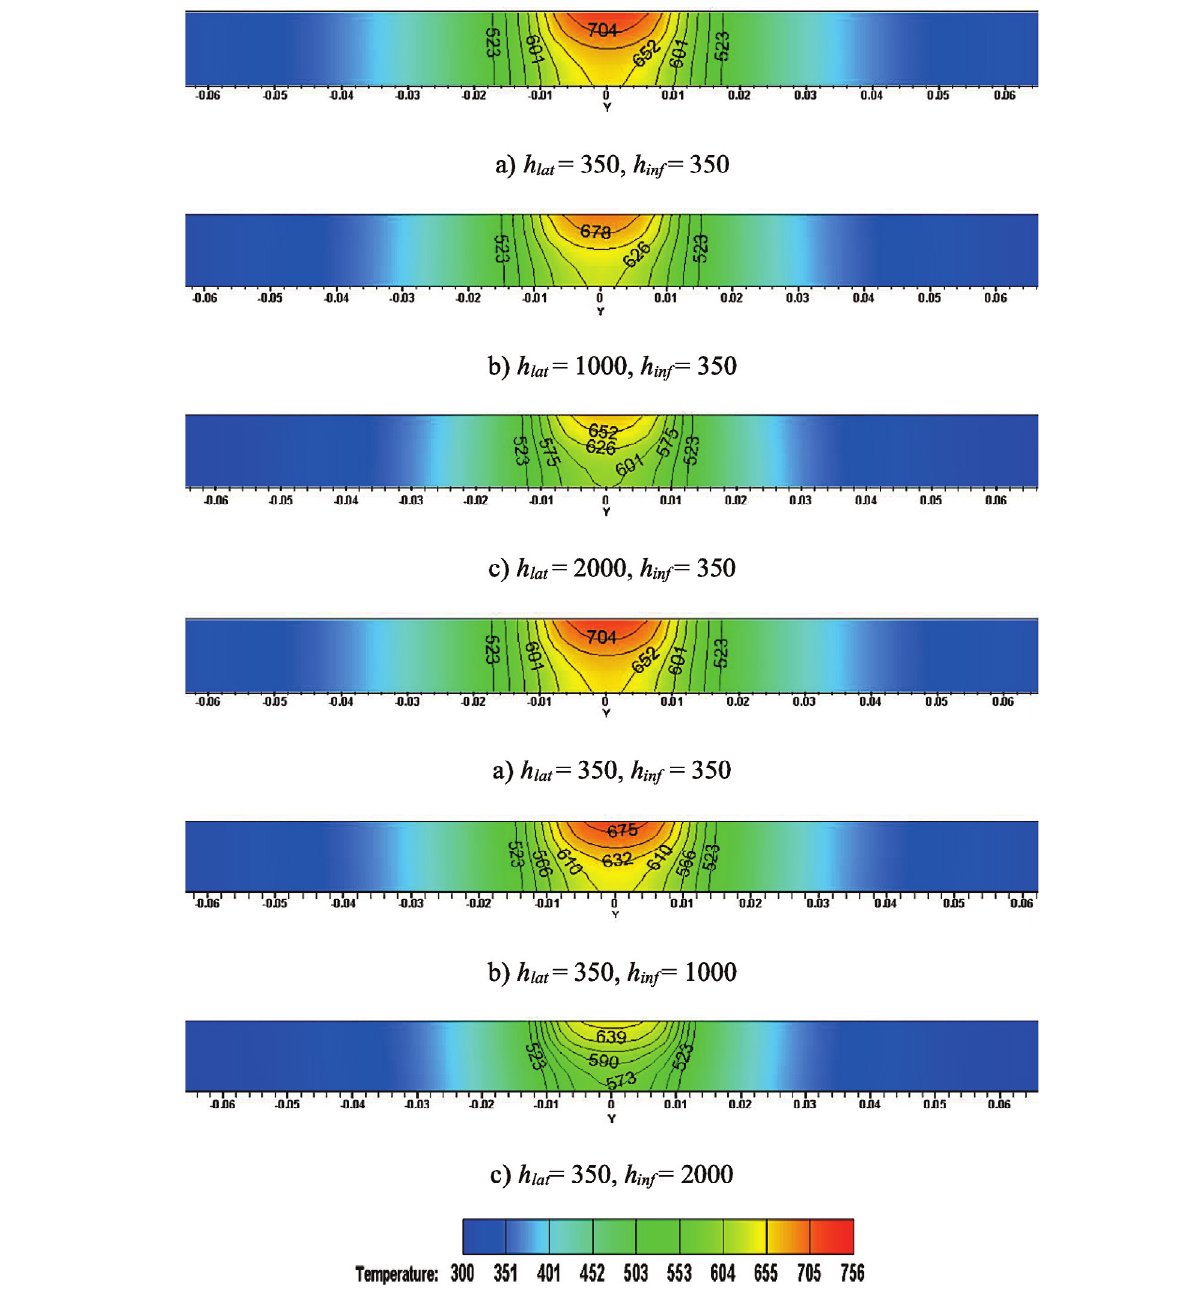
Fig. 5 . Effect of h lat and h inf on the thermal field in the plane perpendicular to the welding direction at x = 305 mm ( u w = 3 mm/s, w = 400 tr/min, F = 15 kN, R S = 12.7 mm )